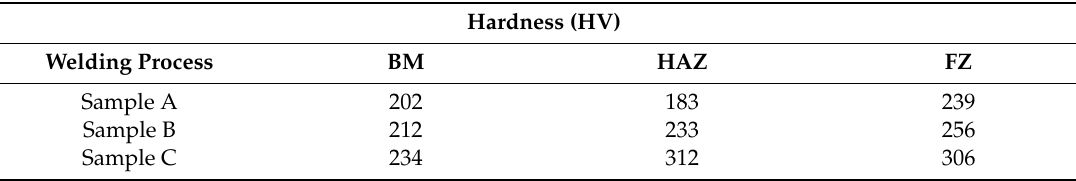
Table 3. Hardness for the di ff erent regions of the joint.